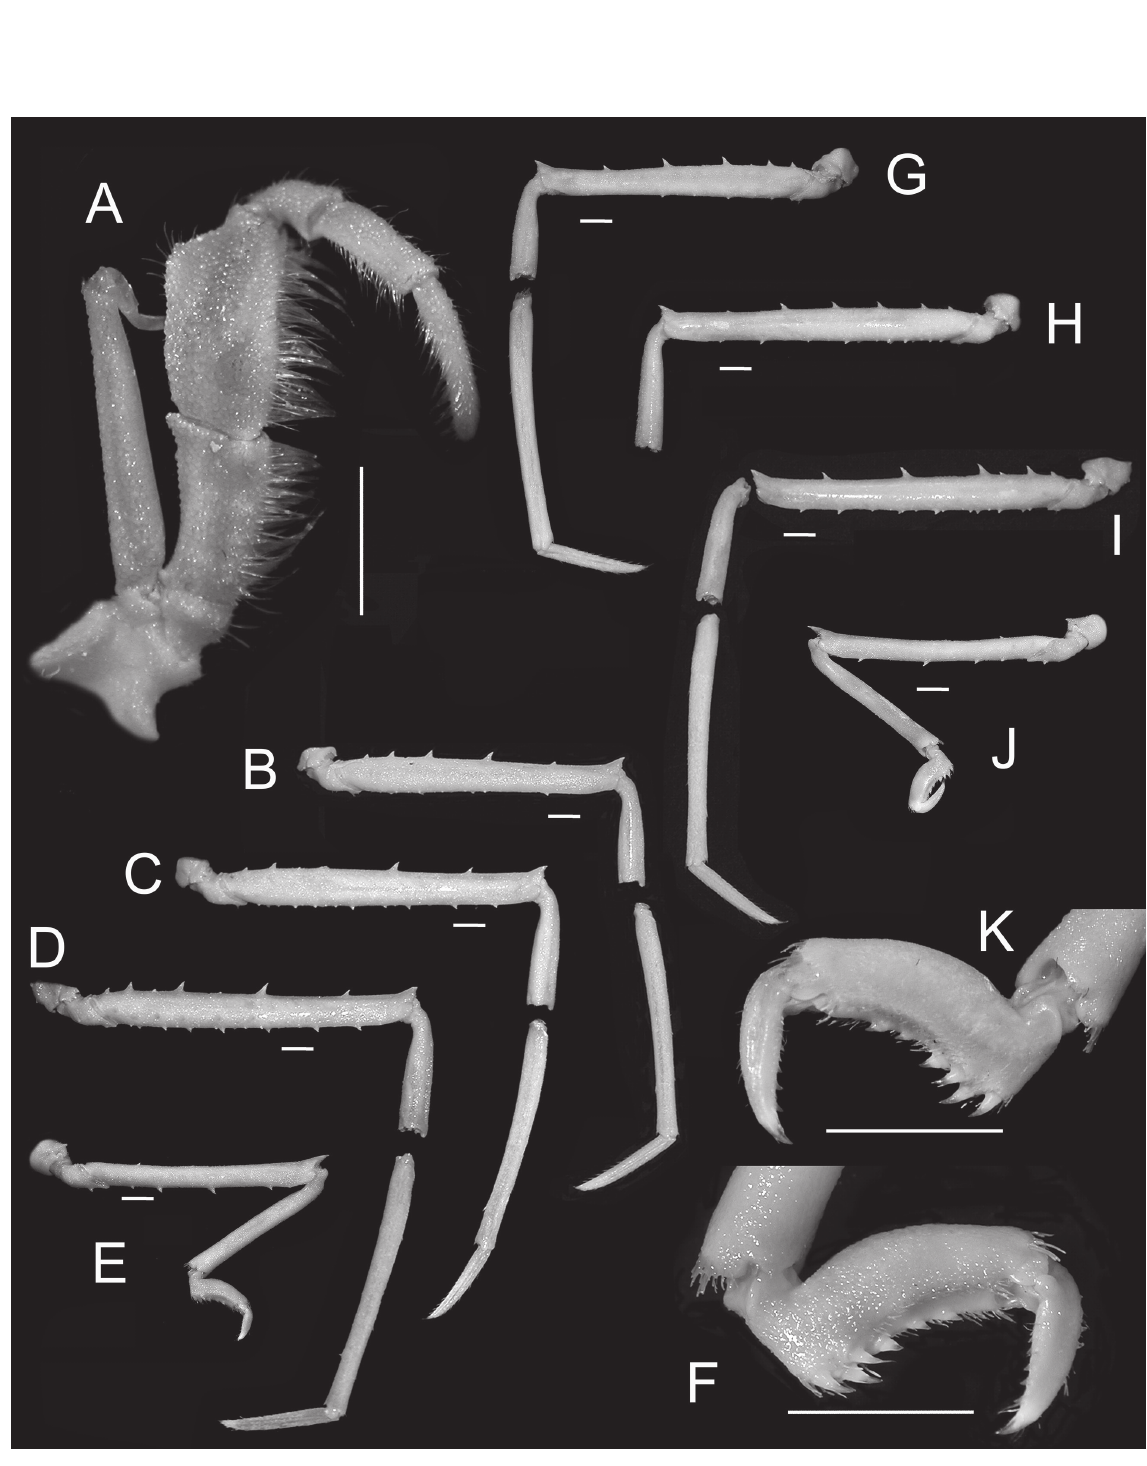
Fig. 11. Moloha alisae Guinot & Richer de Forges, 1995. Holotype, ♂ (cl 36.1 mm, cw 29.7 mm) (MNHN-IU-2008-11077), Seychelles. A . Right third maxilliped. B – E . Right P2–P5, respectively. F . Right P5 subchelate dactylus and propodus. G – J . Left P2–P5, respectively. K . Left P5 subchelate dactylus and propodus. Scale bars = 5